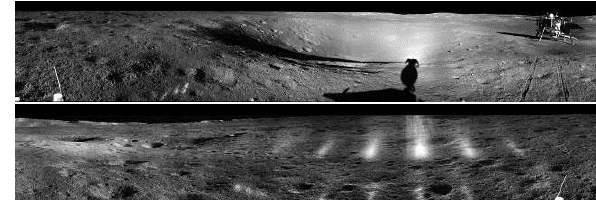
Figure 10. A Pancam image mosaic generated from images taken in the first lunar day.